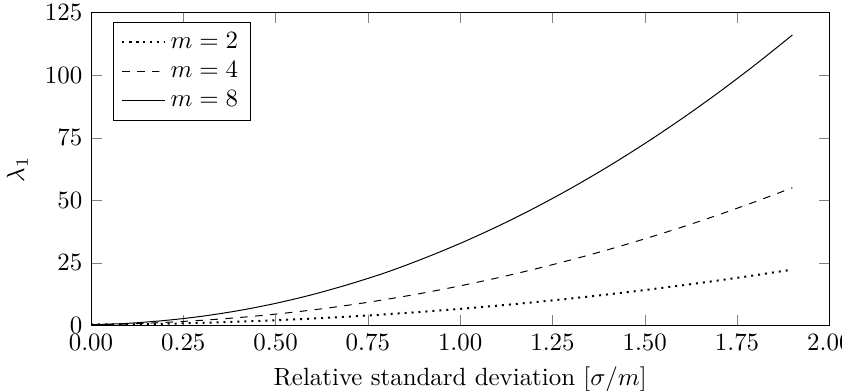
Figure 2: Noise parameter λ 1 as a function of the relative standard-deviation σ/m for the noisy Hamming-weight leakage function defined by f ( x ) = wt ( x ) + e with e ∼ N (0 , σ 2 ).